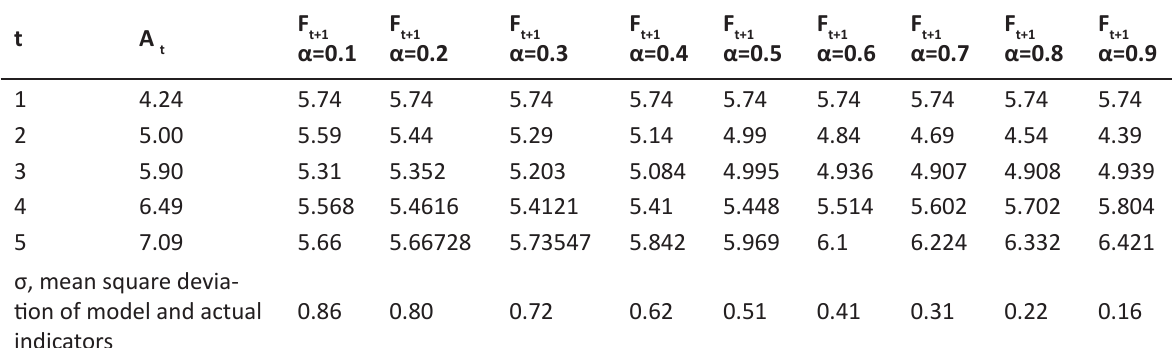
Table 5. Mean square deviations of model and actual indicators in experimental group in October 2015.